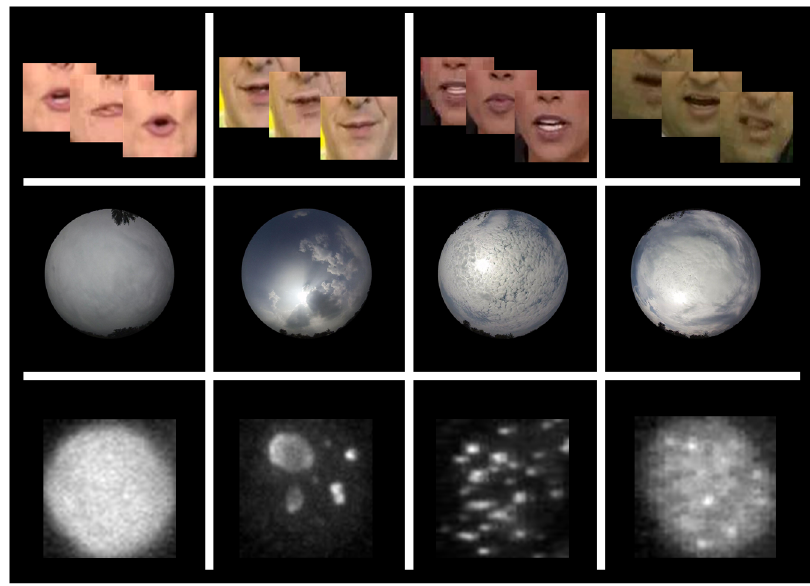
Figure 1. Some representative data examples of the related problems. The first row corresponds to the lip-reading classification task, where each sample is an image sequence (29 frames) for when one word is spoken; the second row shows fisheye images of different types of clouds for the all-sky cloud classification task, and the third row presents IIF cell images for the HEp-2 cell classification task. Obviously, local rotation invariance is a sought-after property for all tasks.